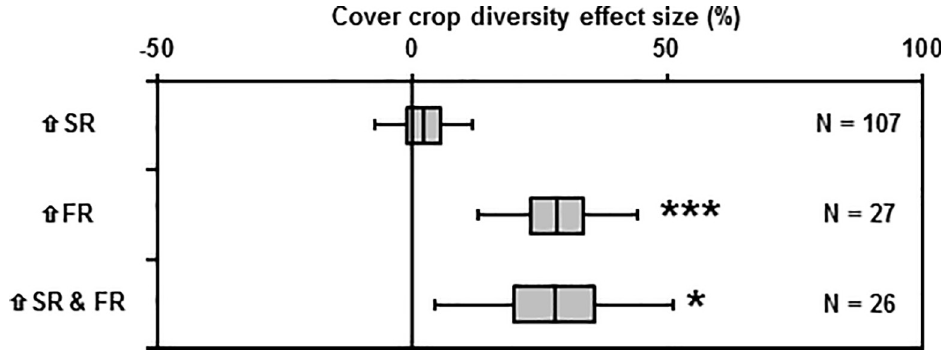
Fig 2. Effect of diversity on biomass productivity. Mean effect size of increasing cover crop diversity on cover crop productivity—specifically the effects of increasing species richness ( ⇧ SR), increasing functional richness ( ⇧ FR), and increasing both species and functional richness simultaneously ( ⇧ SR & FR). Boxes and bars represent 50% and 95% confidence intervals, respectively. N = number of observations for each estimate. One observation is missing from the ⇧ SR & FR category. Asterisks indicate p -value for the following test—H 0 : μ = 0; H a : μ 6¼ 0. P -value > 0.05 (no asterisk); < 0.05( � ); < 0.01( �� ); < 0.001( ��� ).